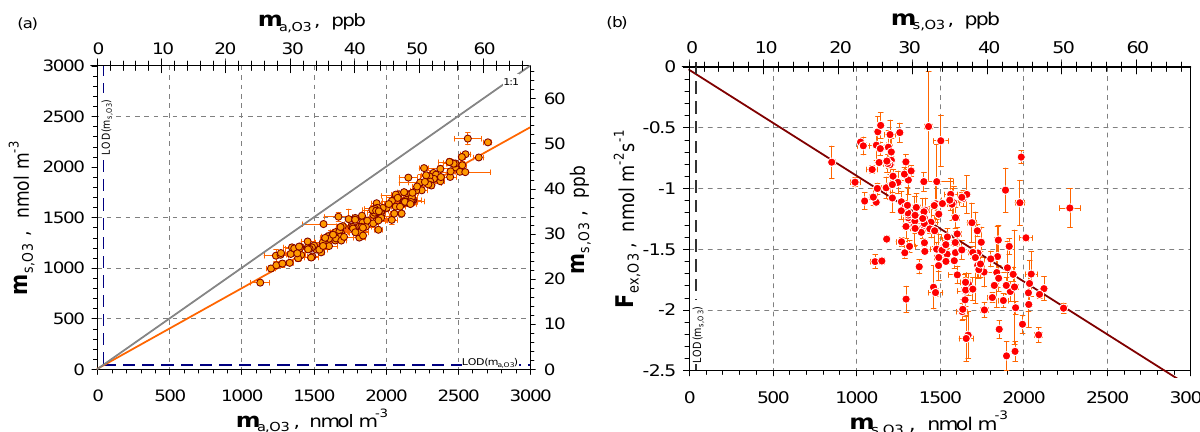
) vs. O 3 concentration 3 − m =( m a,O s,O 3 ). 3 3 data were calculated according ). F ex,O 3 3